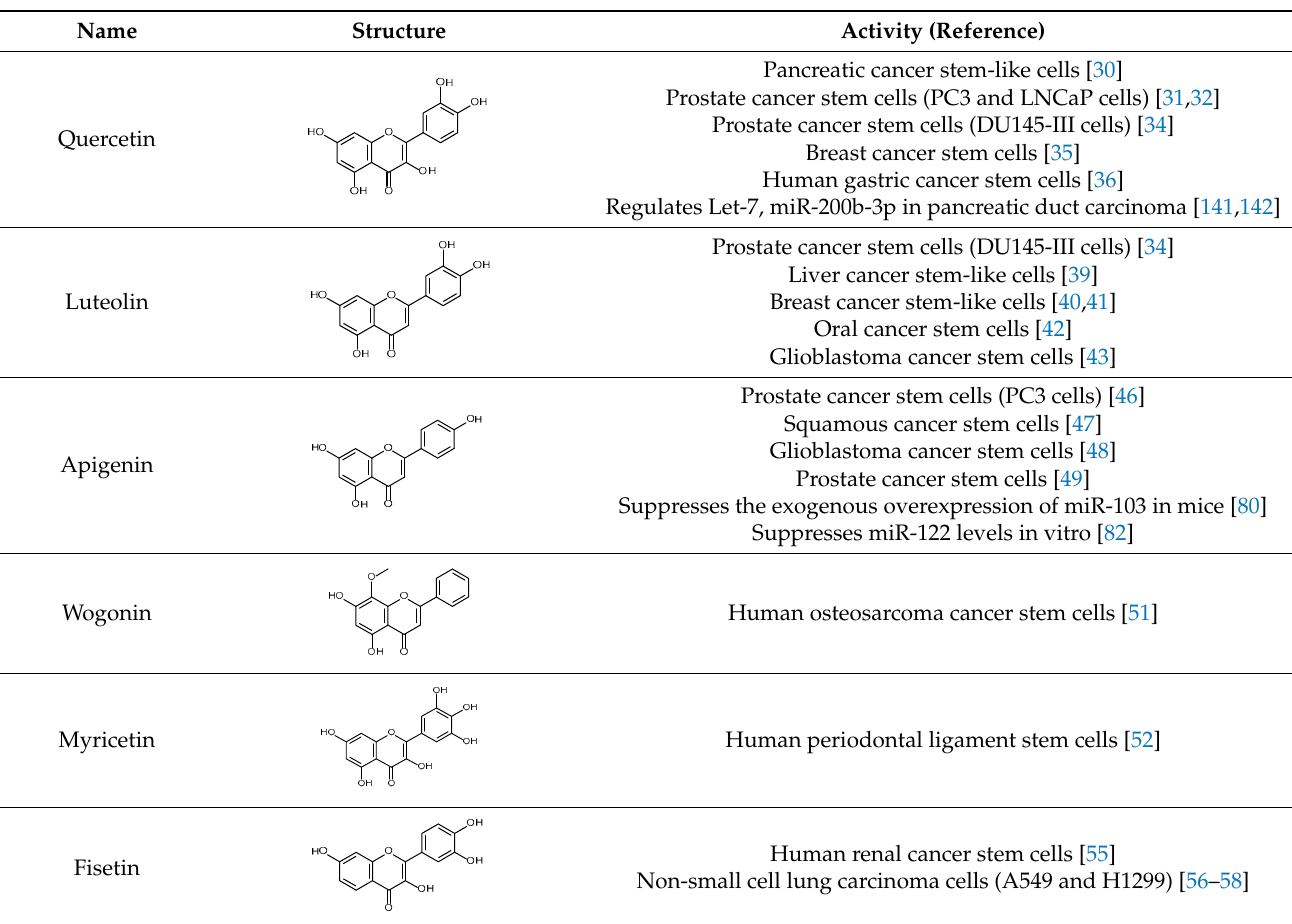
Table 2. A summary of findings regarding NP effects in CSC, including those mediated by microRNAs.